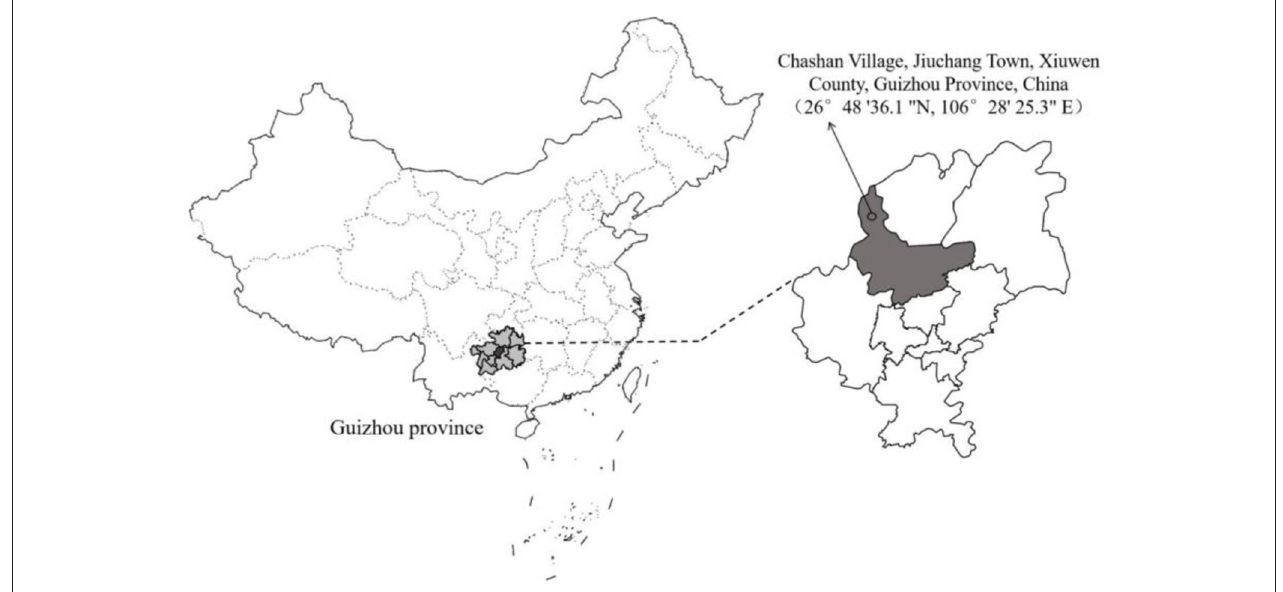
FIGURE 1 | The map of the experimental